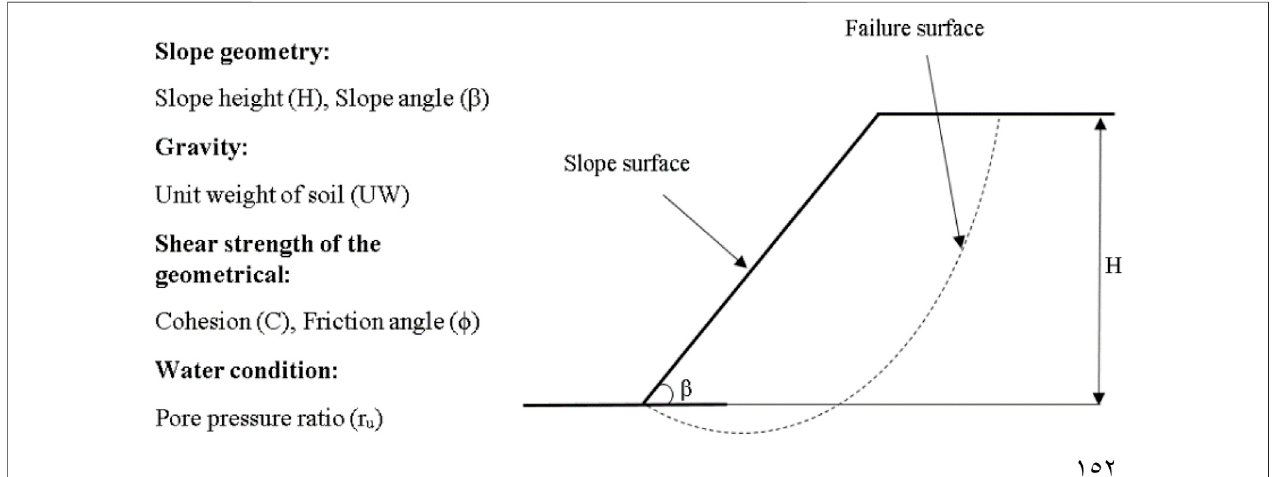
FIGURE 2 | Effective factors affecting the stability of slopes undergoing circular